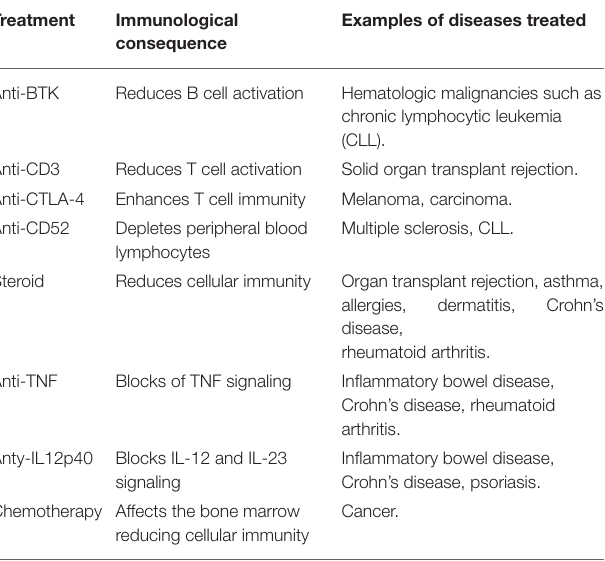
TABLE 4 | Treatments that affect the immune system and predispose to nocardiosis.